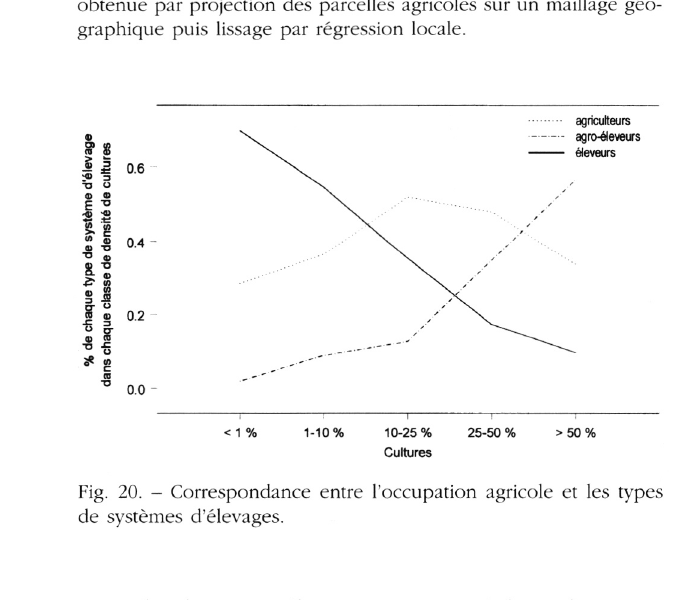
Fig. 20. - Correspondance entre l’occupation agricole et les types de systèmes d’élevages.